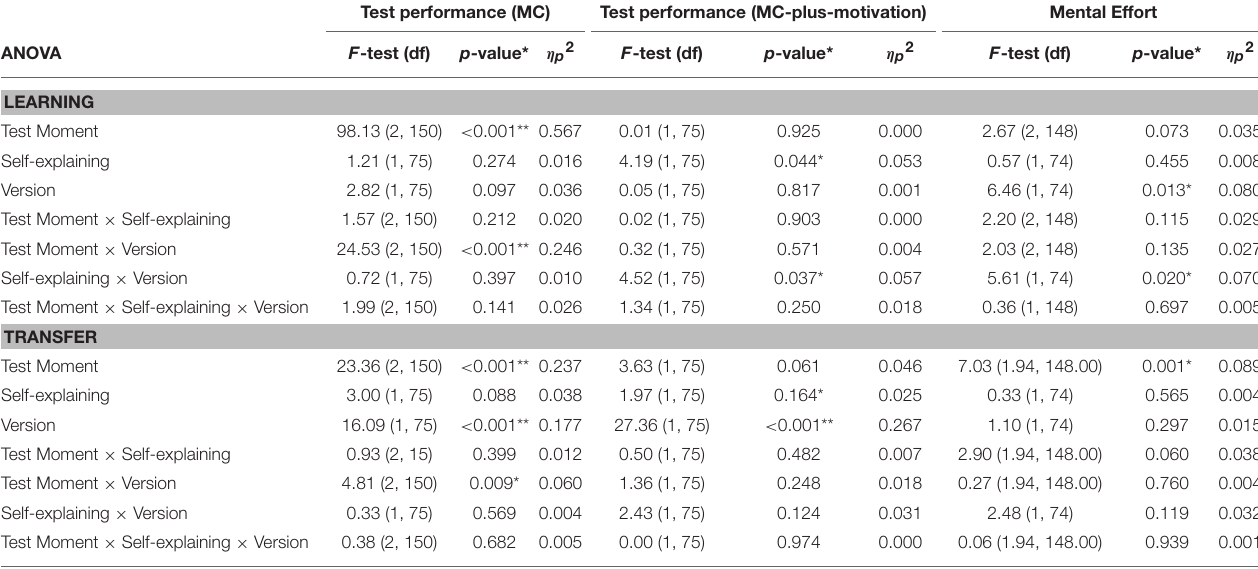
TABLE 3 | Results Mixed ANOVAs. Test performance (MC) Test performance (MC-plus-motivation) Mental